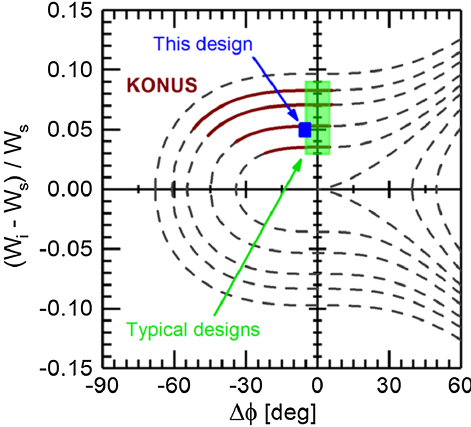
FIG. 7. Typical starting Δ ϕ and Δ W for the 0° sections and the choices for the 6